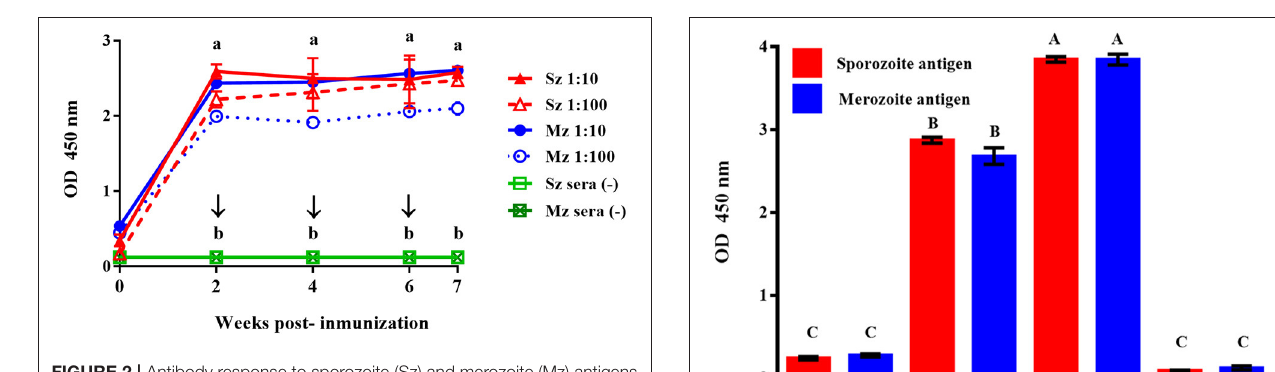
FIGURE 2 | Antibody response to sporozoite (Sz) and merozoite (Mz) antigens in SPF Leghorn chickens immunized subcutaneously with whole sporozoites of E. tenella . Sera dilutions of 1:10 (continuous lines) and 1:100 (dotted lines) are shown. The arrows indicate the boost immunizations at intervals of 2 weeks. Sera from the four unimmunized birds (–) did not show any reactivity with Sz and Mz antigens. At each time point, the arithmetic means ± standard deviations of absorbance units (O.D.) of sera collected from four chickens are shown. The line plots denoted as a are significantly different ( P < 0.05, according to Tukey’s multiple range test) from those denoted as b.